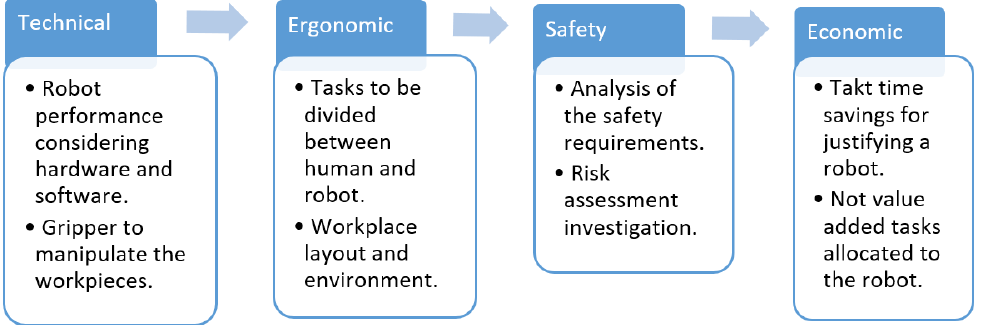
Figure 2. Managerial evaluation analysis. The technical evaluation considers the technologies available (robot arm, gripper, sensors), the new workstation configuration (shop floor space), computational systems to be integrated (interfaces, hardware, and software limitations), and even the experience and training of workers. Technical issues might be a critical variable when implementing a cobot. Ergonomic evaluations were already discussed during the first assessment. Especially when deciding which tasks are to be allocated to the worker, the new workstation also needs special ergonomic considerations. Postures (workstation layout), frequency of repetitive actions, workloads, and time pressure as well as safety requirements. The new productivity goals are limited by ergonomic and safety issues. Therefore, when evaluating economics, every variable is important. The economic evaluation might be estimated considering the non-value added tasks that will be automated [14], as these tasks usually consume time and production resources. Therefore, it is possible to